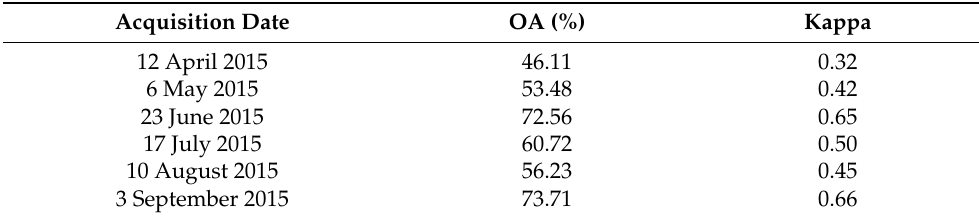
Table 6. Accuracy assessment of RF classifications using single-date SAR image with all polarimetric observables.